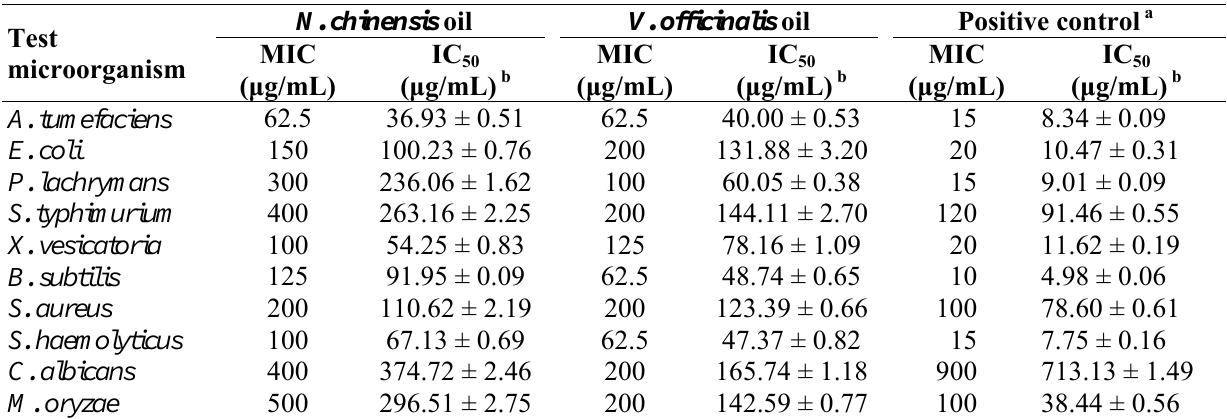
Table 2. Antimicrobial activity of the essential oils from N. chinensis and V. officinalis